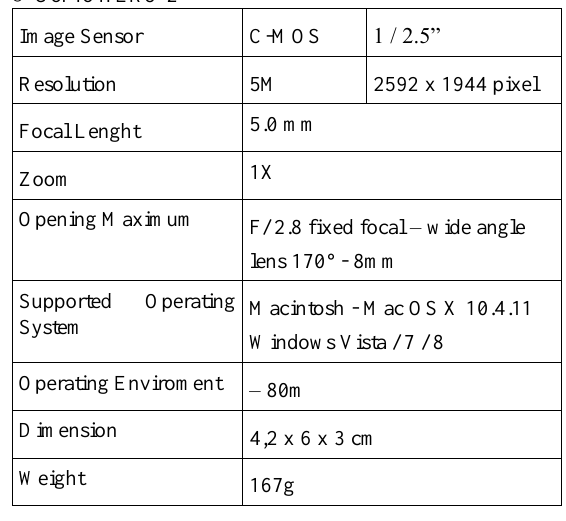
Table 3. Main characteristics of GoPro camera